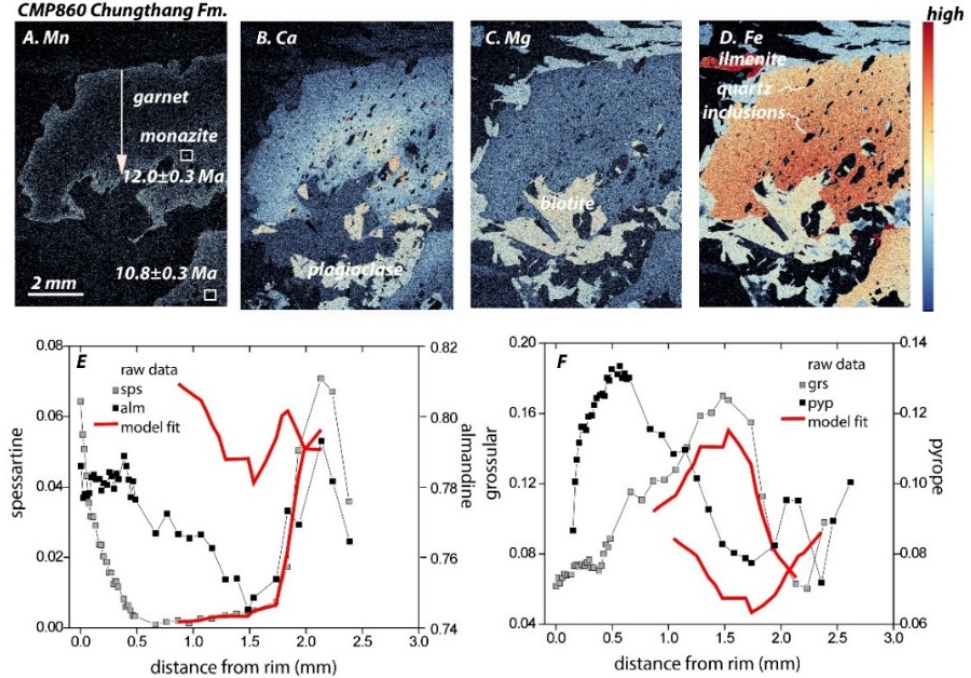
Figure 7. X-ray element maps of sample CMP860 (Chungthang Fm) in ( A ) Mn, ( B ) Ca, ( C ) Mg, and ( D ) Fe. Garnet compositions in spessartine (sps) and almandine (alm) (panels E ) and grossular (grs) and pyrope (pyp) (panels F ) were taken across the rim to rim transects identified in panels ( A ) and ( E ). The red lines in panels ( E , F ) show the prediction of the high-resolution P-T paths generated for this sample. Monazite inclusions in garnet were dated in this sample by [5], who also reported the compositional data.